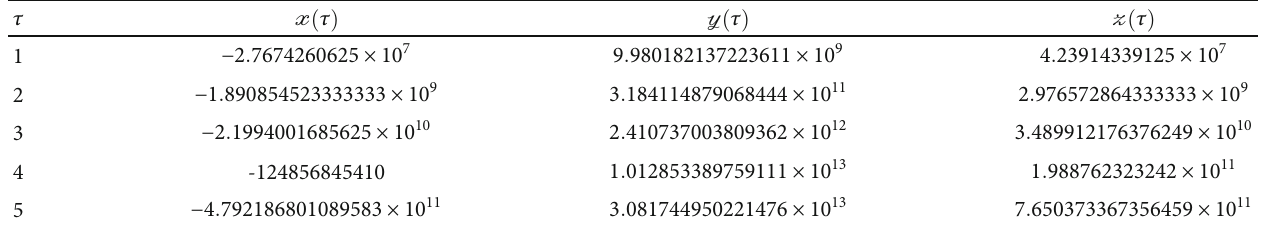
Table 3: Numerical outcome of Equation (29) for p = 1 , q = 1 , ð a , b , c Þ = ð − 10, 0, 37 Þ , and ð d , ℯ , f Þ = ð 35, 3, 28 Þ . τ x τ ð